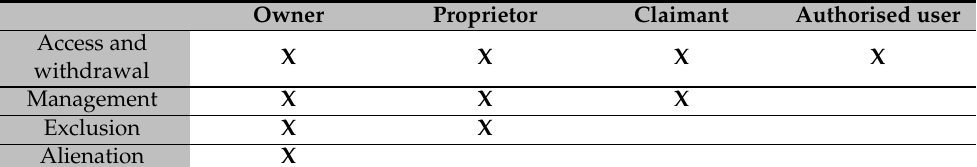
Table 2. Bundles of rights associated with positions. Source: